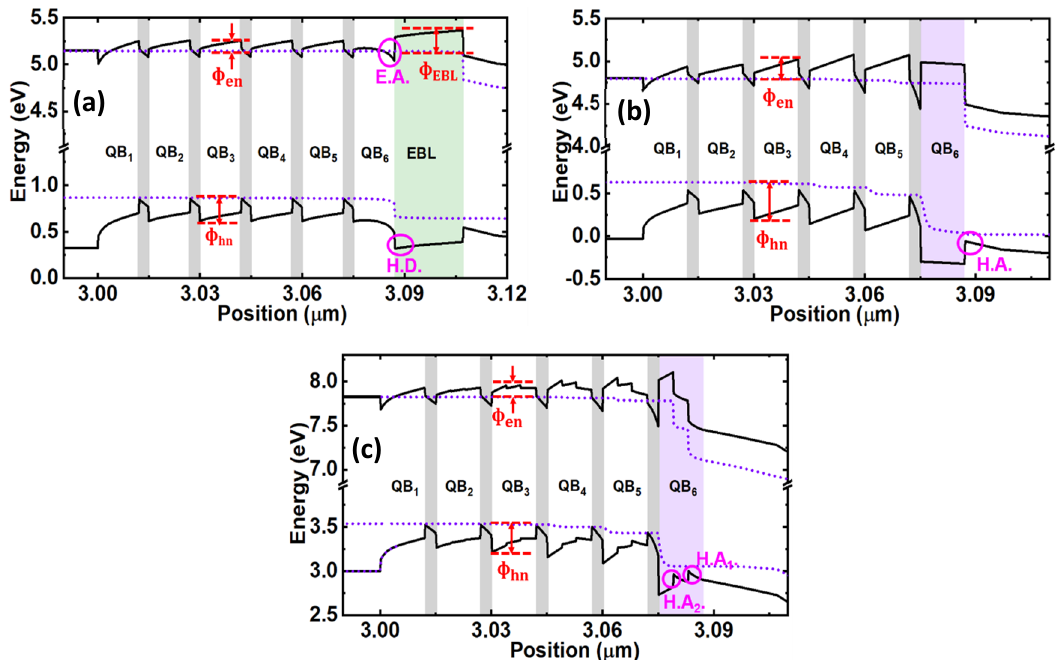
Figure 2. Measured and calculated light-current-voltage characteristics of LED 1 for model validation [21].